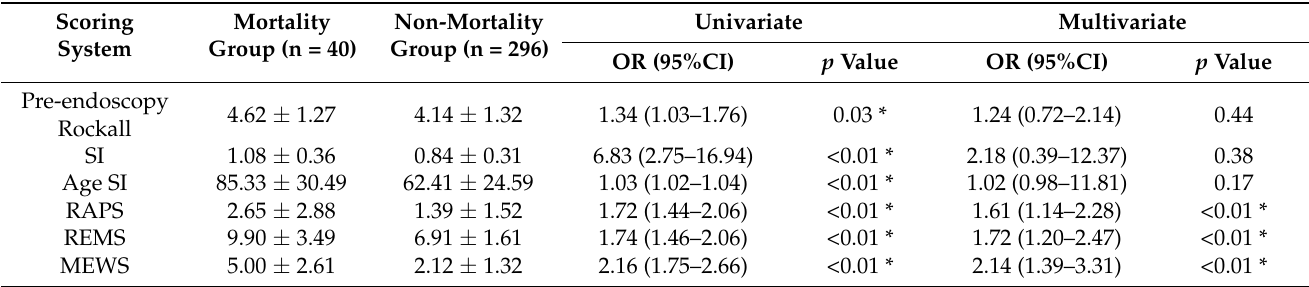
Table 6. Comparison of six scoring systems between the two